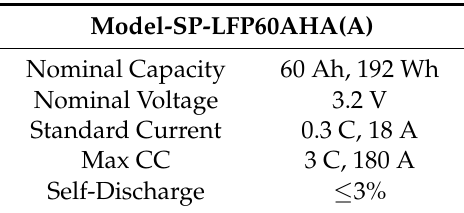
Table 1. Specifications of the 60 Ah LFP